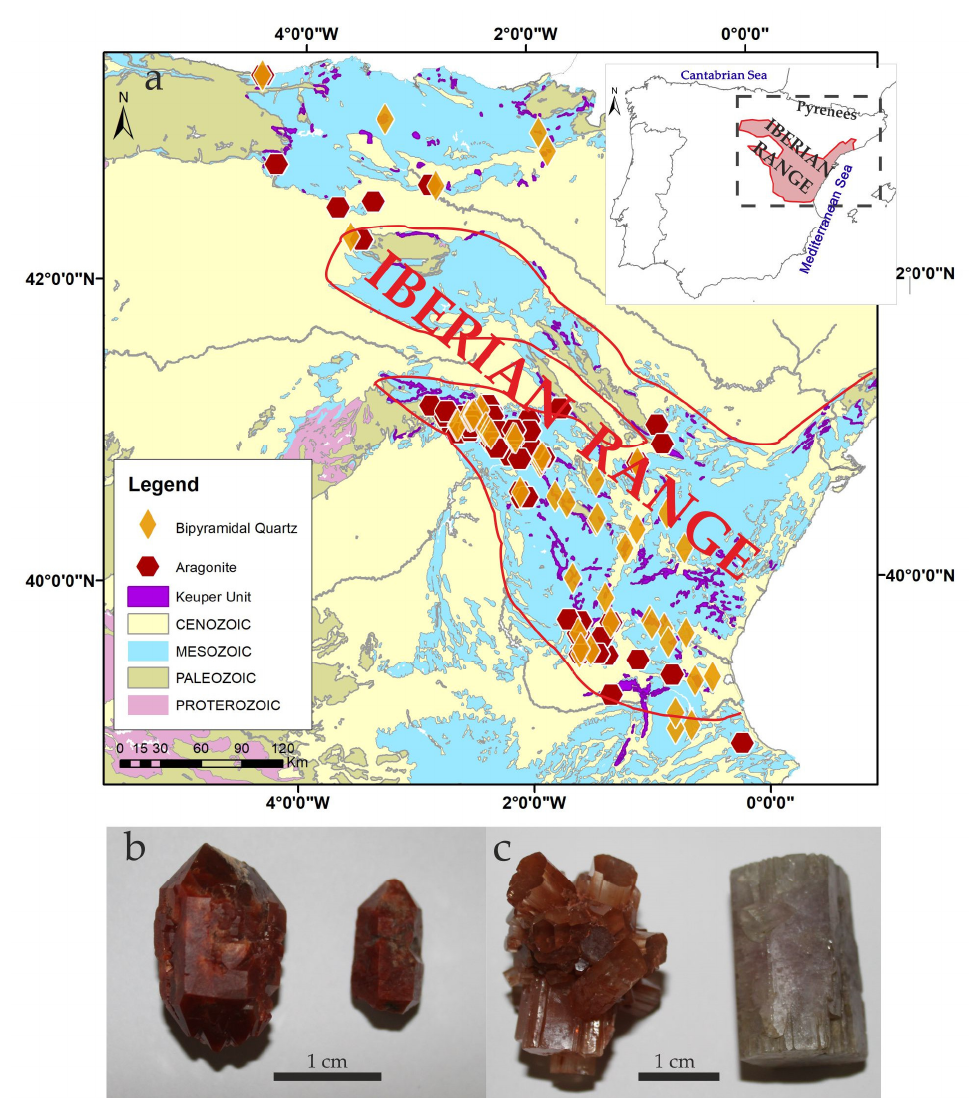
Figure 1. ( a ) Location of the bipyramidal quartz and aragonite crystals in the Iberian Range (Spain); ( b ) Bipyramidal quartz crystals that commonly are red-colored; ( c ) Pseudohexagonal aragonite prisms and rosettes, which show a wider color variation.